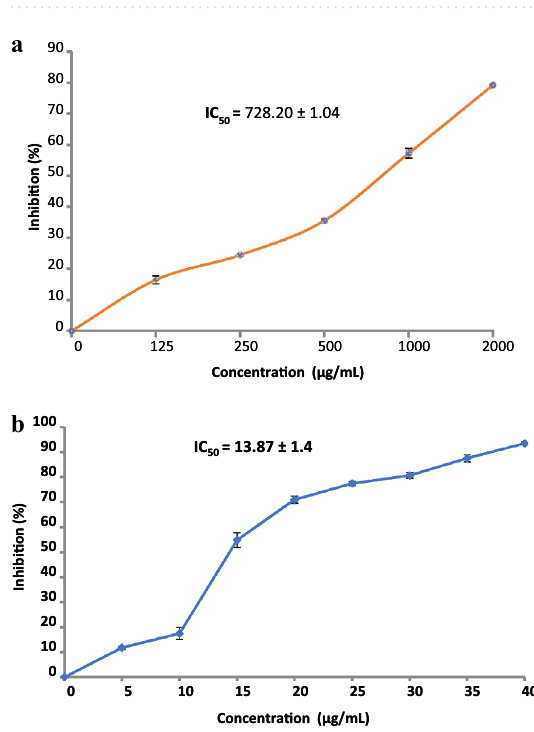
Figure 3. GC/MS chromatogram analysis of D. caffra fruits extract.